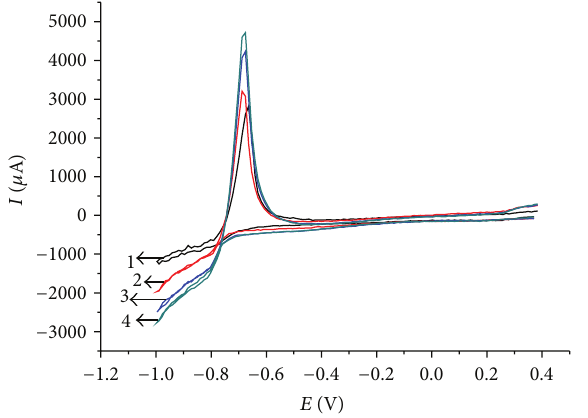
Figure 4: Cyclic voltammograms of Tl + ( 𝑐 = 10 −3 molL −1 ) at a glassy carbon electrode at different stirring rates, V = 20 mV/s. The electrolyte was 0.5 molL −1 Na 2 SO 4 , pH = 7. (1) 100rev/min, (2) 250 rev/min, (3) 500 rev/min, and (4) 750 rev/min.